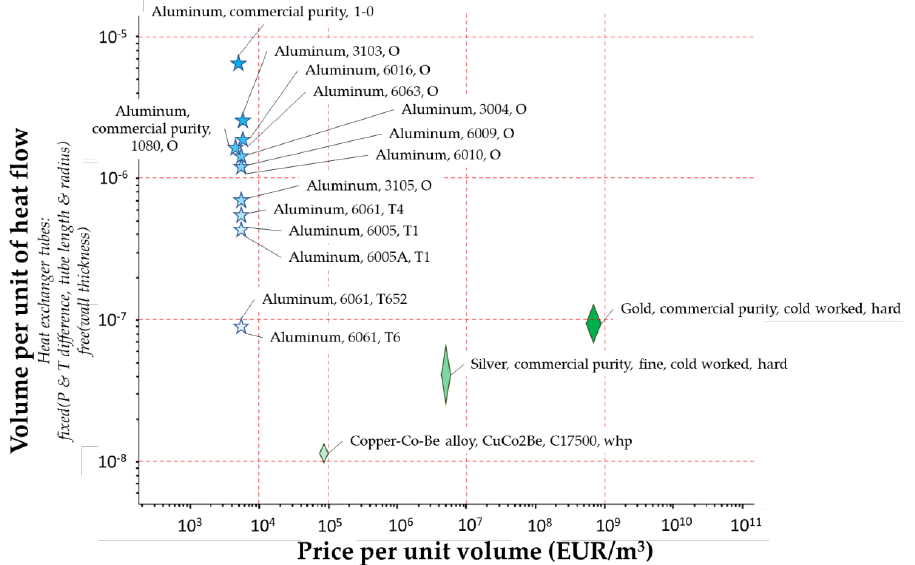
Figure 1. Comparison of some materials used in heat exchanging applications. Chart and data from CES EduPack 2019, Granta Design Limited, Cambridge, UK, 2019 [12].